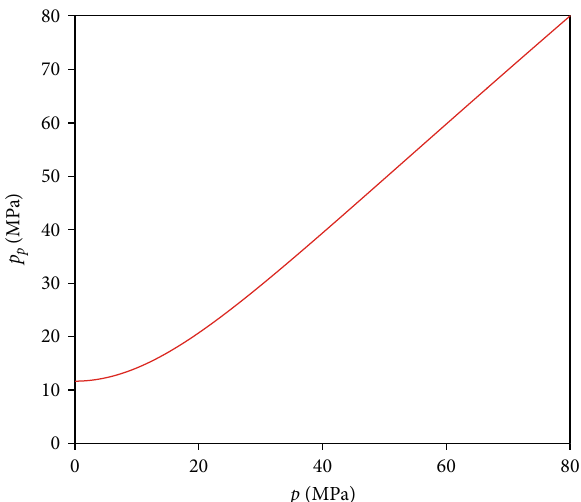
Figure 23: The estimated pro fi le of G